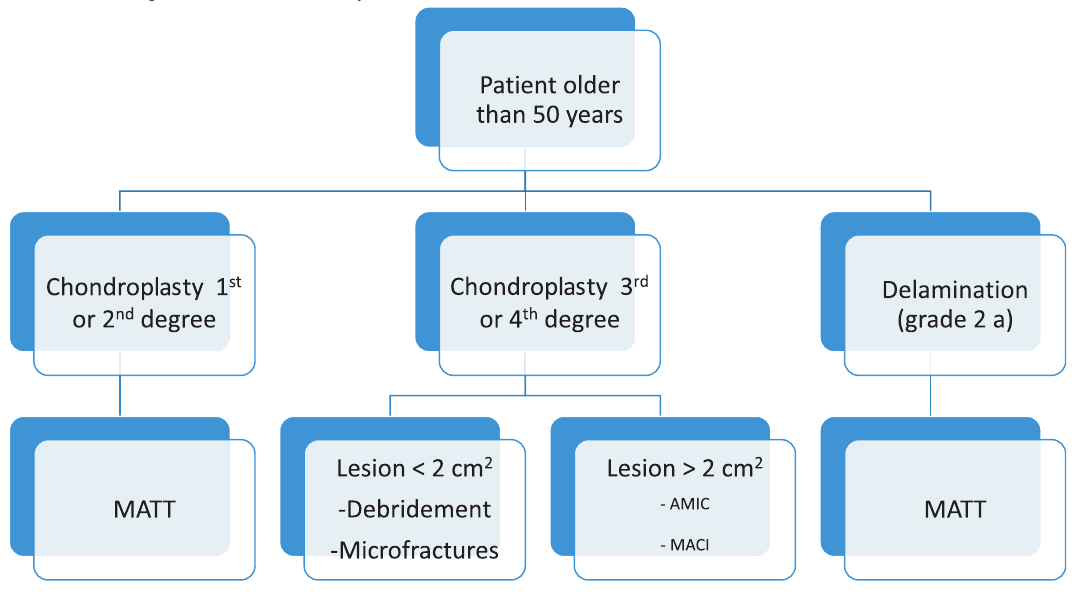
Table 2. Decision tree for patients older than 50